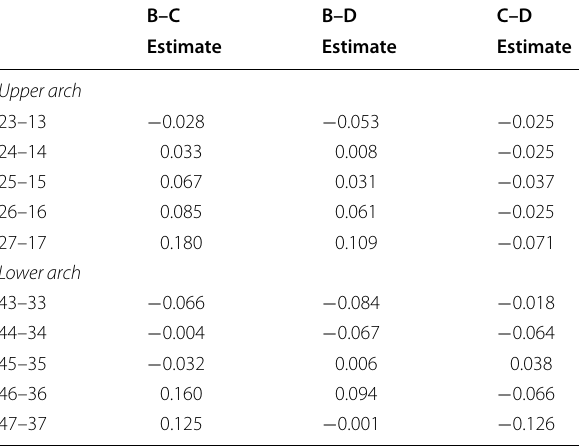
Table 5 Comparison between units B (Carestream CS 3600), C (CEREC Omnicam) and D (Trios 3Shape) for linear measurements (mm)